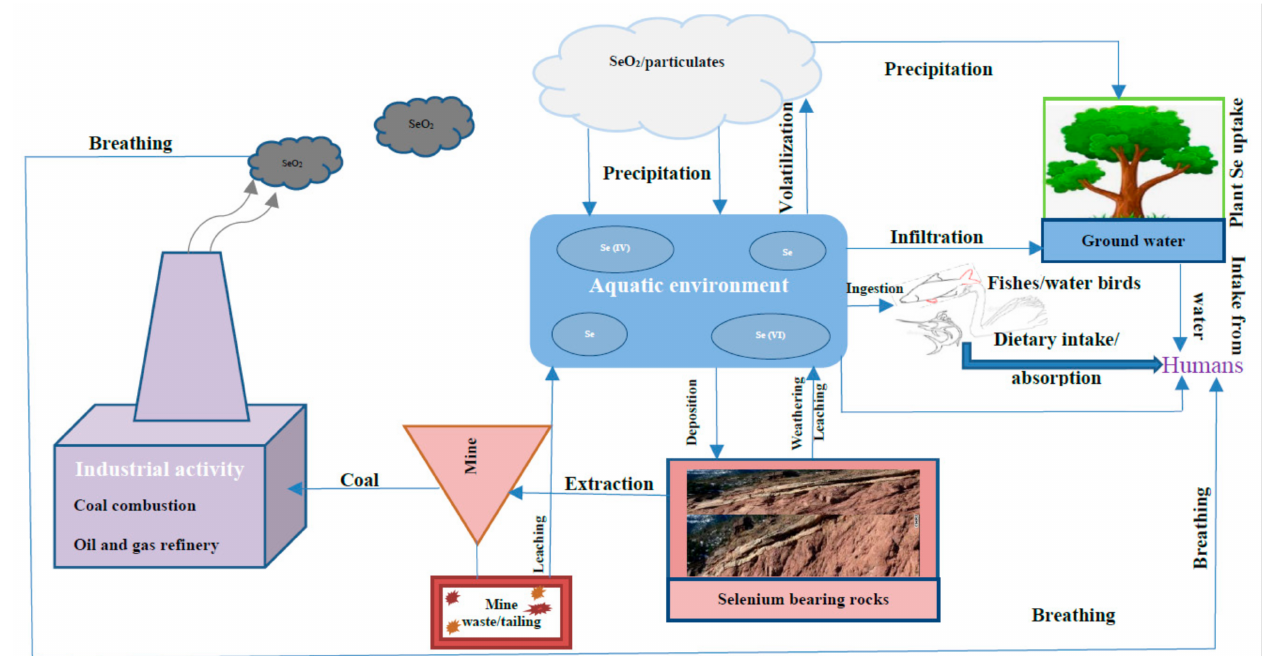
Figure 1. Schematic illustration of selenium cycling in the environment and the human intake